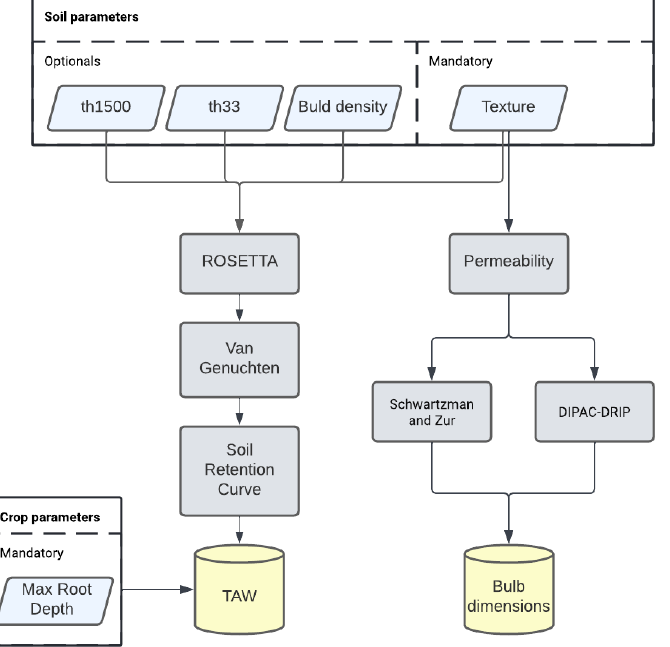
Figure 7. Flowchart of the procedures for calculating TAW and wet bulb dimensions. Where th1500 and th33 are the soil water content at soil matric potentials of −1500 and −33 kPa, respectively. Calculation of Total Available Water